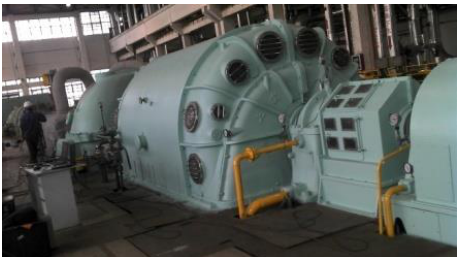
Figure 3. The illustration of a 50 MW turbo generator unit.